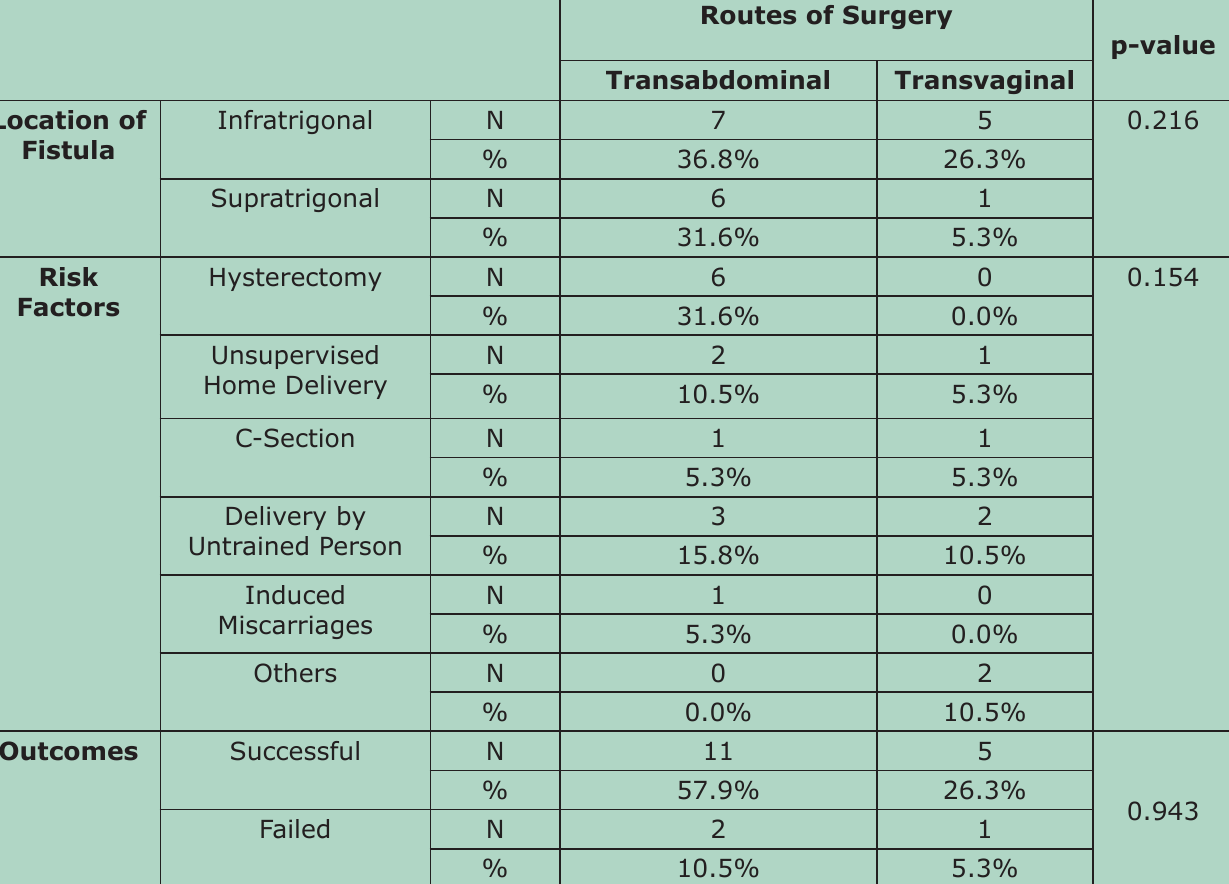
Table-I: Comparison between Transabdominal and Transvaginal routes of surgery on the base of Location of fistula using Chi-square test.